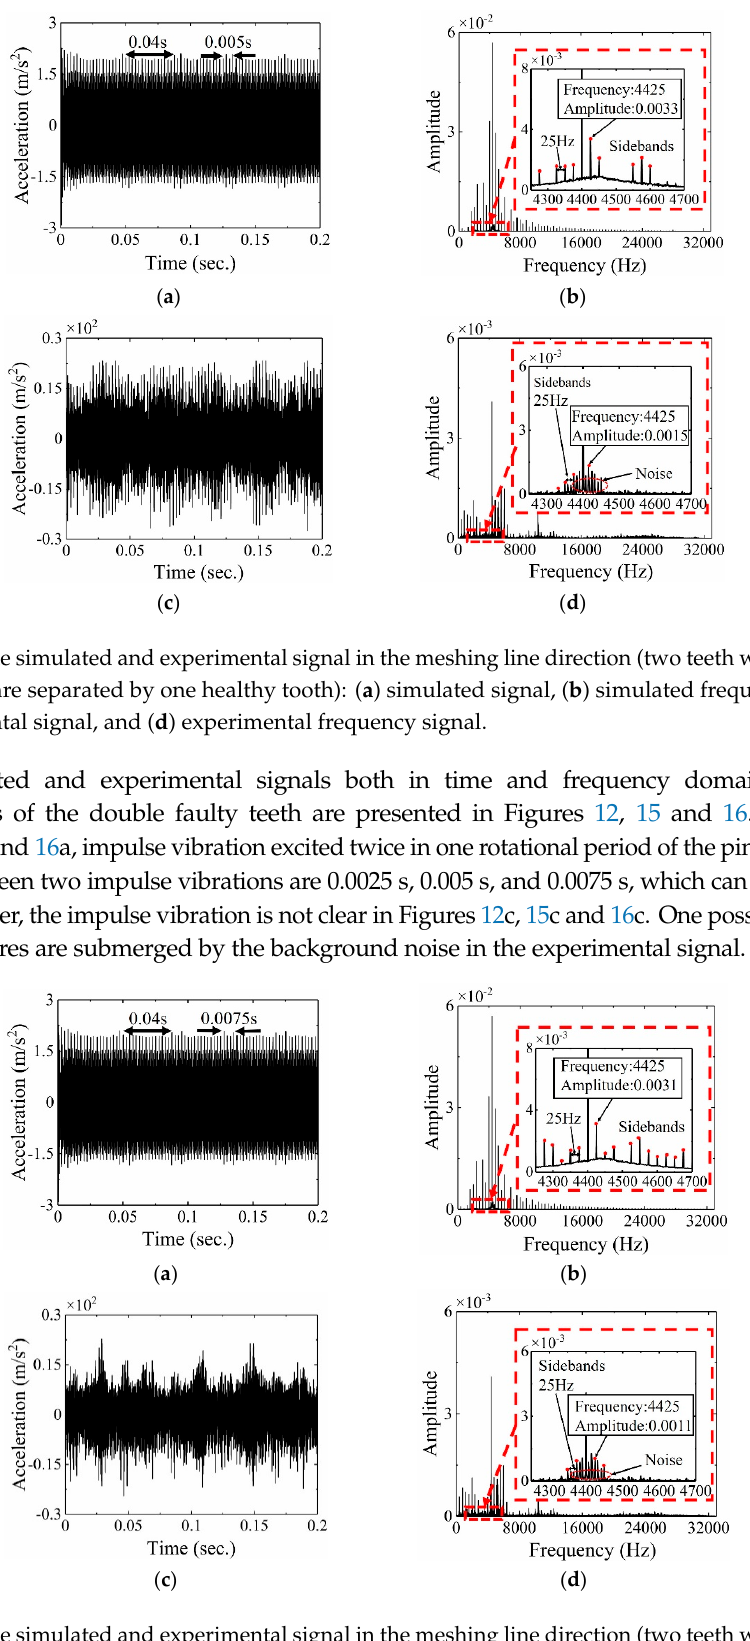
Figure 16. The simulated and experimental signal in the meshing line direction (two teeth with spalling fault, which are separated by two healthy teeth): ( a ) simulated signal, ( b ) simulated frequency signal, ( c ) experimental signal, and ( d ) experimental frequency signal.